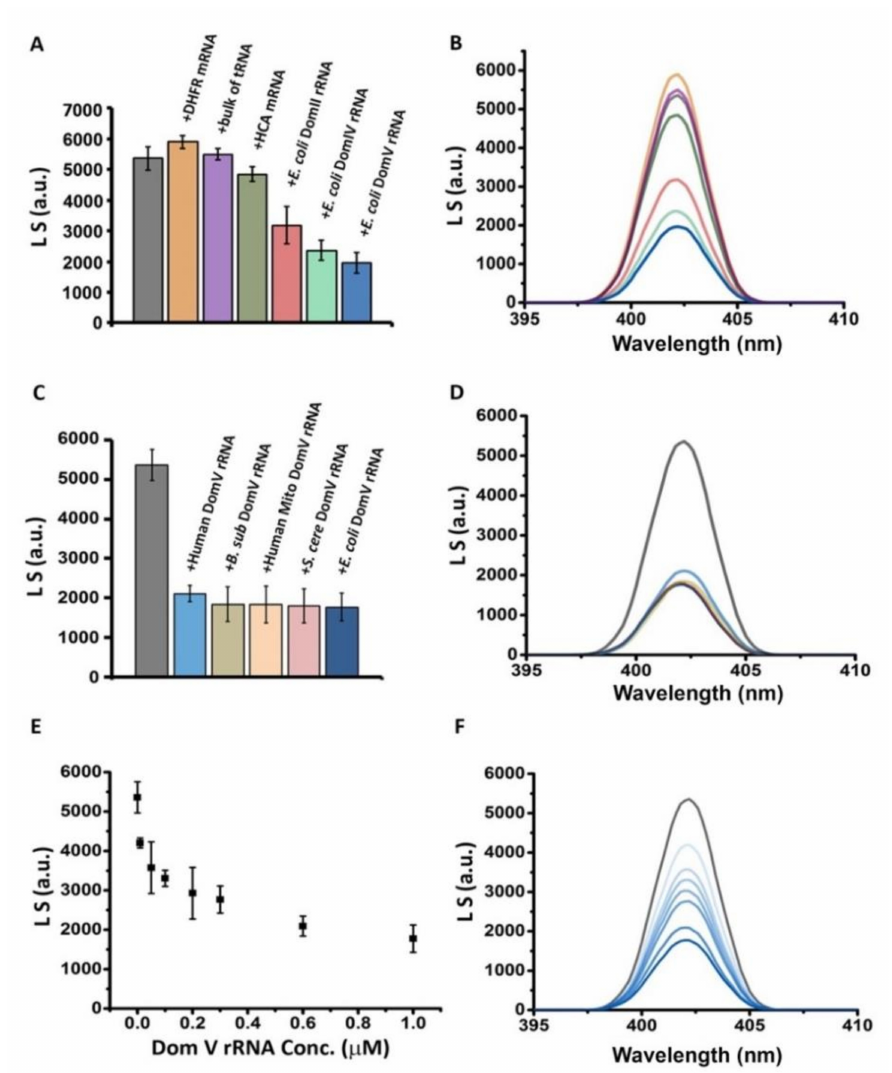
Figure 1. The e ff ect of RNAs in HET-s aggregation as followed by Rayleigh light scattering at 402 nm. HET-s protein stored in a denatured condition in 8 M urea was diluted in 50 mM Tris-HCl pH 7.5 to a final concentration of 5 µ M and incubated without or with di ff erent RNA samples (~1 µ M) overnight at 37 ◦ C for aggregation. Then, light scattering was measured with a HITACHI F-7000 fluorescence spectrophotometer. While the left panels show emission peak intensities at 402 nm (excitation 400 nm; average of three to five independent experiments, error bars represent standard deviation), the right panels show representative spectra using the same color codes as in the corresponding left panels. Light scattering from HET-s ( A , B ) without or with di ff erent RNA samples, ( C , D ) with domain V of rRNA from various sources and ( E , F ) with di ff erent concentrations of domain V rRNA from E. coli